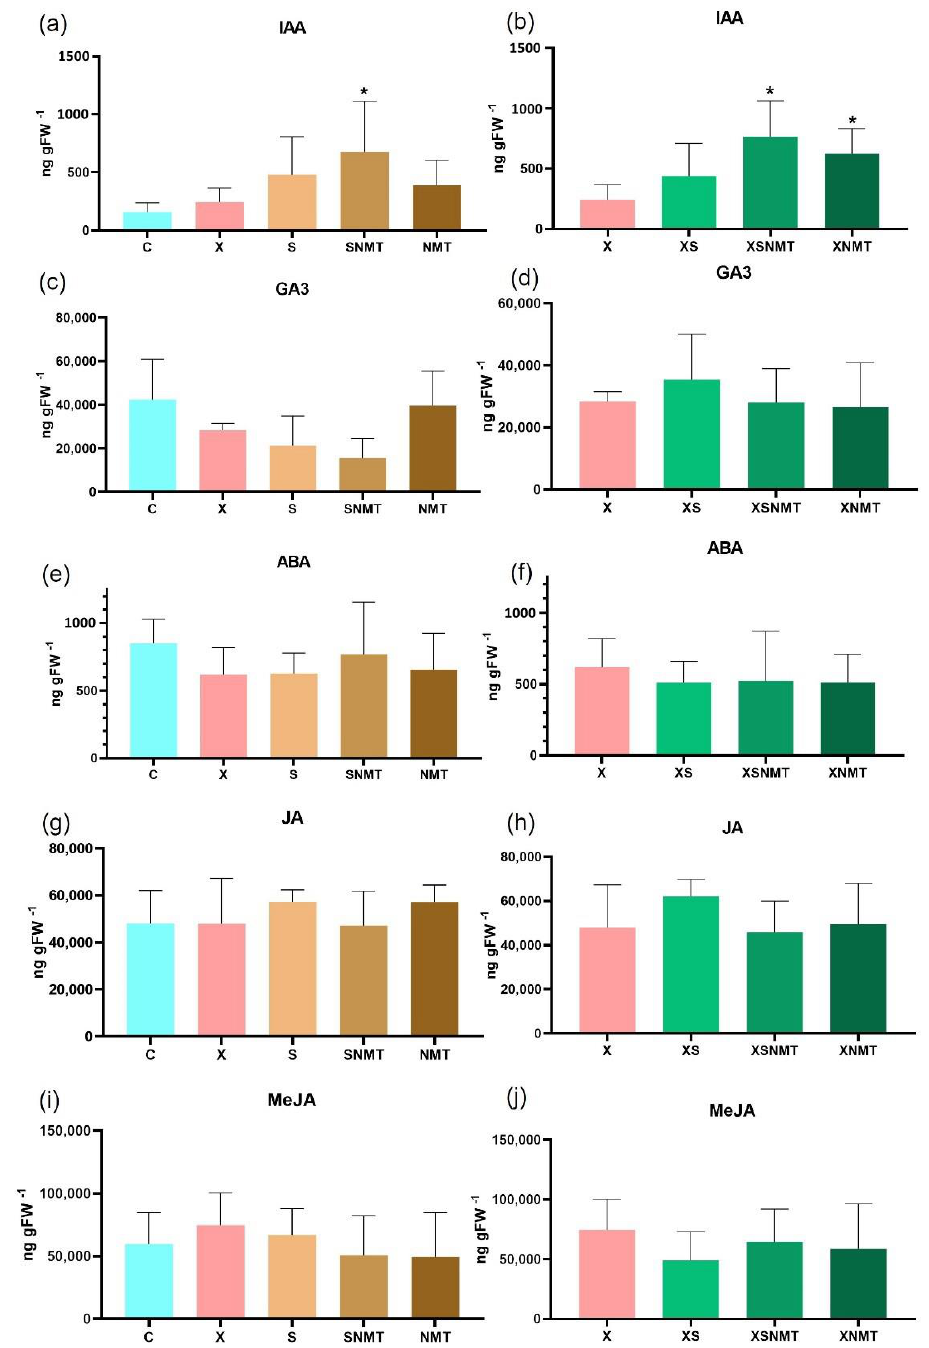
Figure 6. Phytohormone quantification of IAA ( a , b ); GA3 ( c , d ); ABA ( e , f ); JA ( g , h ); and MeJA ( i , j )